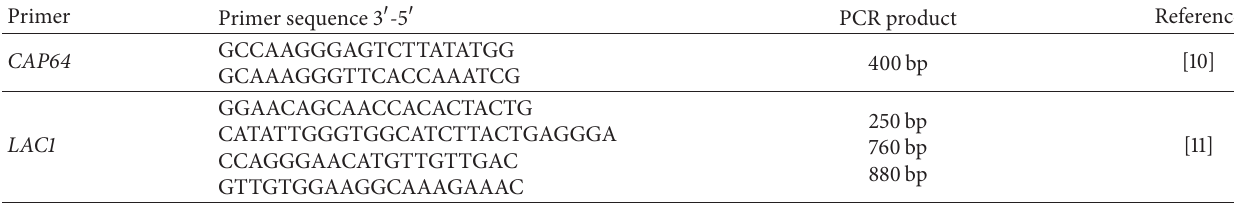
Table 2: Primers used in this study.